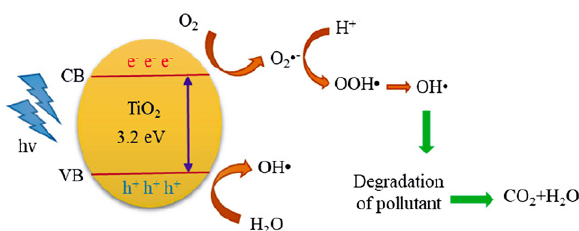
Fig. 1. The schematic diagram of mechanism for photocatalytic degradation using